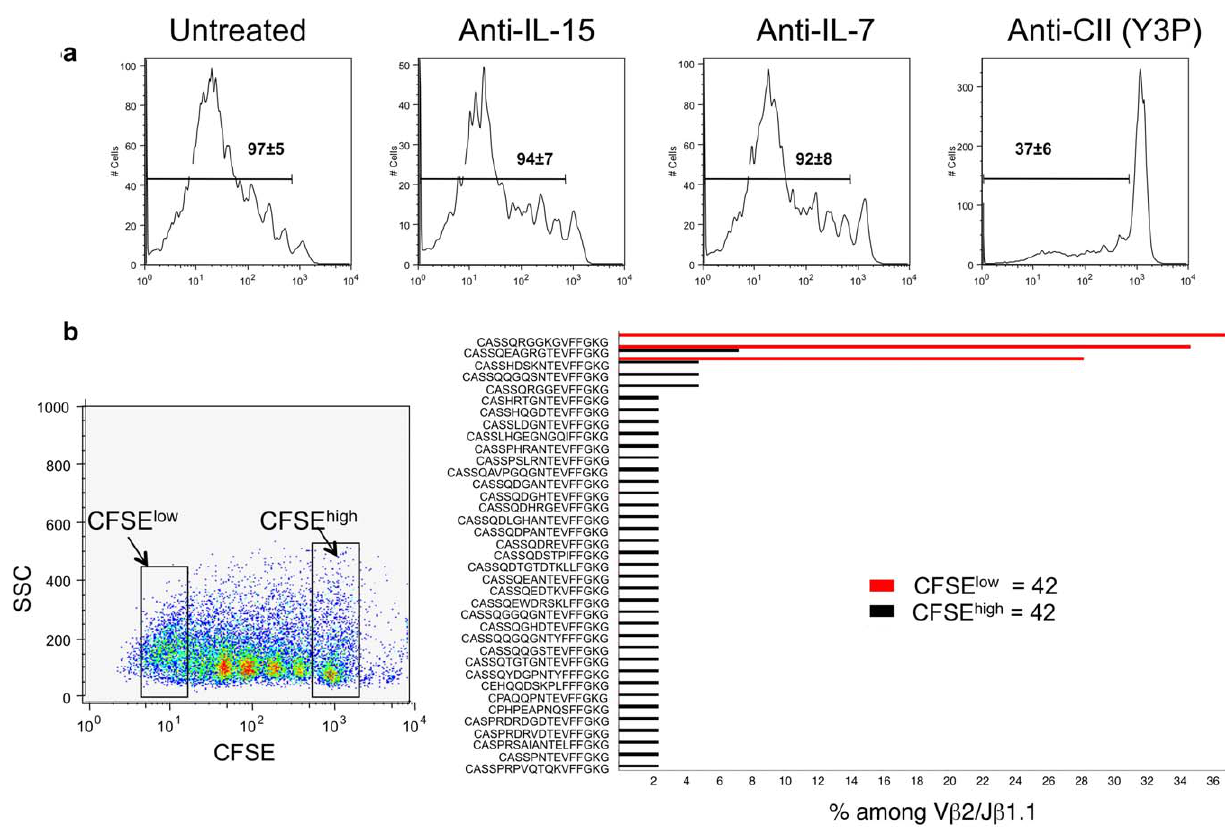
Figure 5. Effect of anti–IL-7, anti–IL-15, and anti-MHC class II (CII) on MP proliferation in Rag 2 2 / 2 mice. (A) 1 million CFSE-labeled MP CD4 T cells were transferred into Rag 2 2 / 2 mice that received a single dose of 0.5 mg of anti–IL-7, anti–IL-15, or 1.8 mg of Y3P or were untreated. On day 3, the mice received a second dose of anticytokine antibody or of Y3P. Mice were humanely killed on day 6 and single cell suspensions from lymph nodes were stained by anti-CD4 followed by flow cytometric analysis of CFSE dilution. Numbers inside the histograms represent the frequency of cells that have divided at least once (mean 6 SD, from three mice per group). (B) 1 million CFSE-labeled MP CD4 T cells were transferred into Rag2 2 / 2 recipients. On day 3, animals were humanely killed and 50 6 10 3 CFSE low and high cells were sorted, followed by PCR amplification using V b 2 and J b 1.1 primers (see Figure 6A). CDR3 sequences from the amplified DNA were plotted according to the frequency with which they appeared among the 42 sequences obtained from CFSE low and high V b 2/J b 1.1 cells,